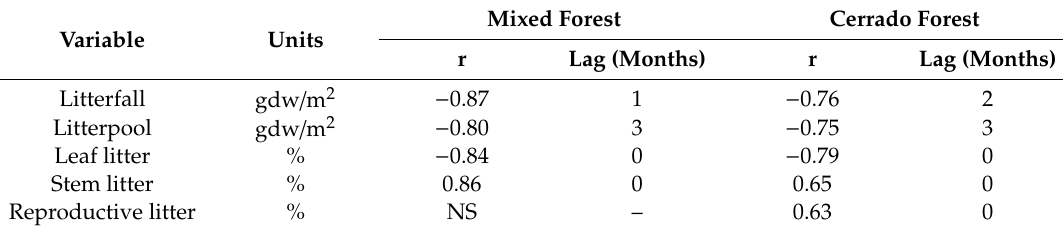
Table 1. Cross-correlation coe ffi cients (r) and time lags between selected average monthly litter production and pool variables and average monthly precipitation over the 2014–2019 study period for the upland mixed and hyperseasonal cerrado forests of the northern Pantanal. A time lag of 0 months indicates that the litter variable was correlated with the precipitation of the current month, while a lag > 0 indicates that the litter variable lagged behind precipitation by the number of months indicated in the lag. N = 12 months, critical r = | 0.576 | , NS = not statistically significant ( p > 0.05). Mixed Forest Cerrado Forest Variable Units r Lag (Months) r Lag (Months) Litterfall gdw / m 2 − 0.87 1 − 0.76 2 Litterpool gdw / m 2 − 0.80 3 − 0.75 3 Leaf litter % − 0.84 0 − 0.79 0 Stem litter % 0.86 0 0.65 0 Reproductive litter % NS – 0.63